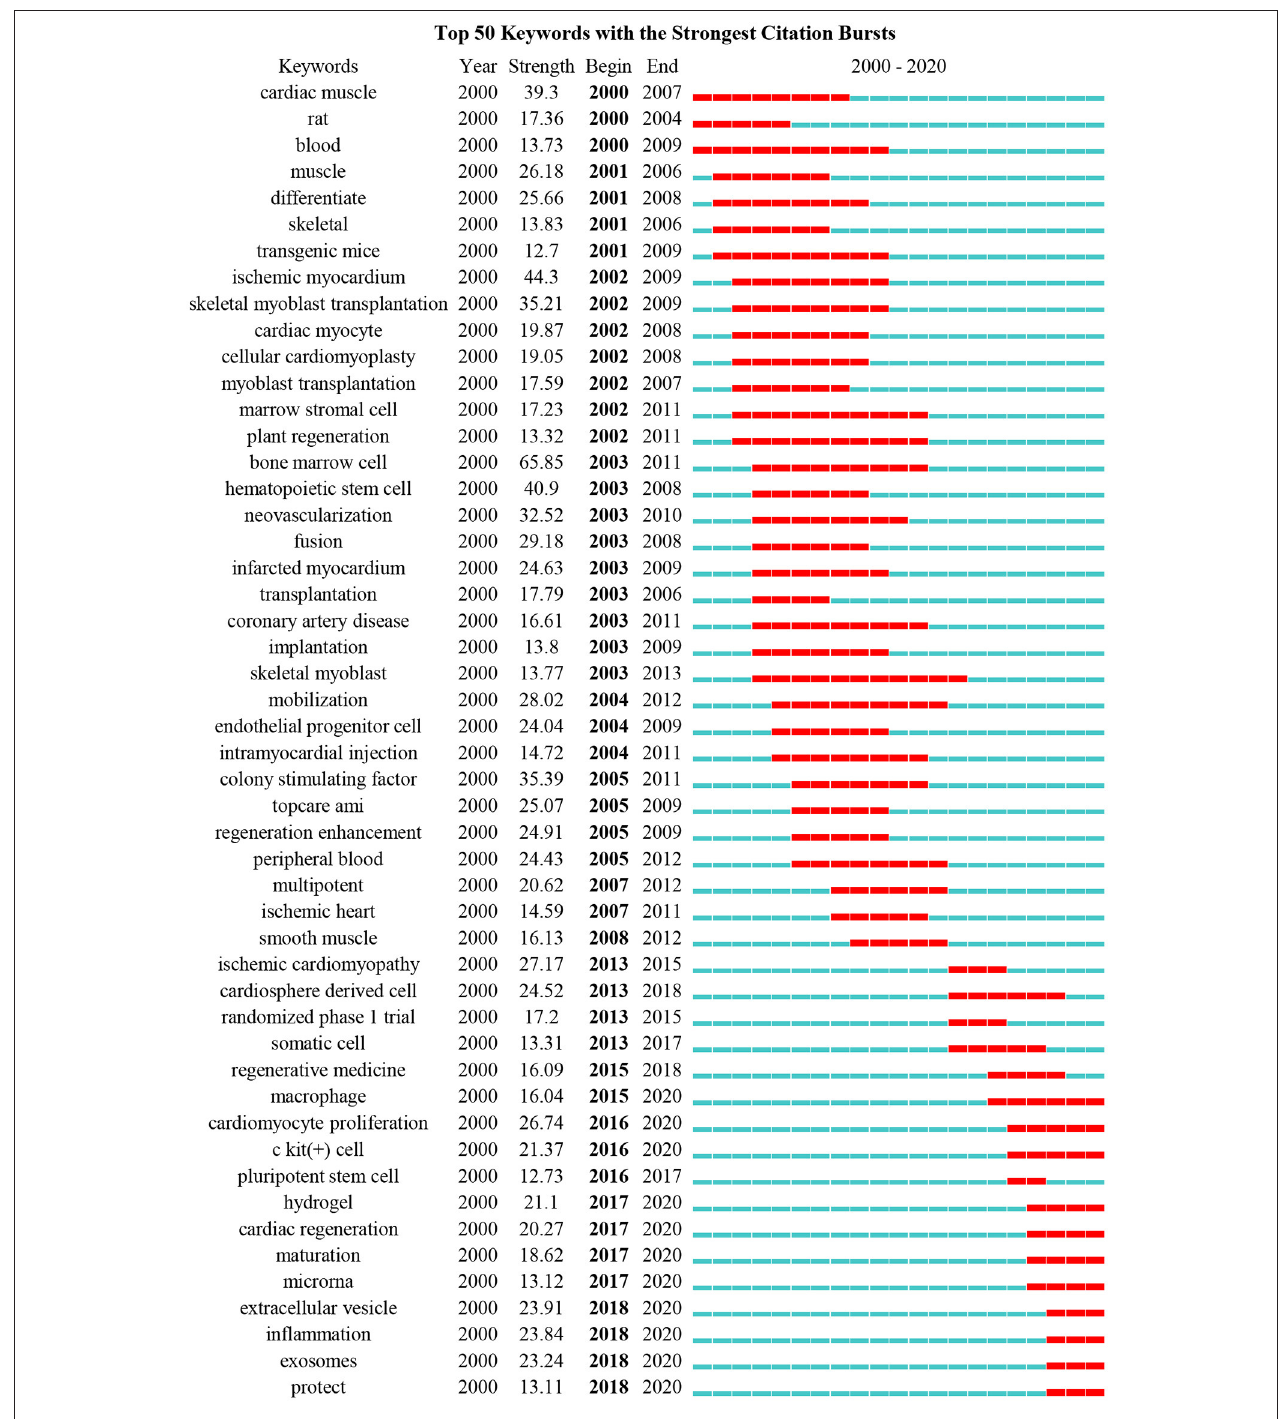
FIGURE 3 | The top 50 keywords with the strongest citation bursts. Thirteen keywords, such as “Regenerative medicine,” “macrophage,” “cardiomyocyte proliferation,” “c-kit ( + ) cell,” “pluripotent stem cell,” “hydrogel,” “cardiac regeneration,” “maturation,” “microrna,” “extracellular vesicle,” “inflammation,” “exosomes,” and “protect,” had the citation burst since 2015.